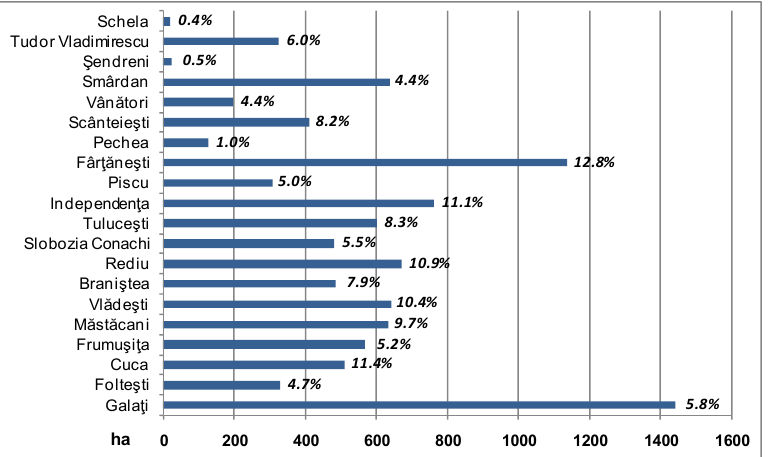
Figure 12. Forest area (ha) and afforestation percentage (%) in 2016, registered by the administrative units of Gala ţ i peri-urban area (Gala ţ i Statistical Division data).